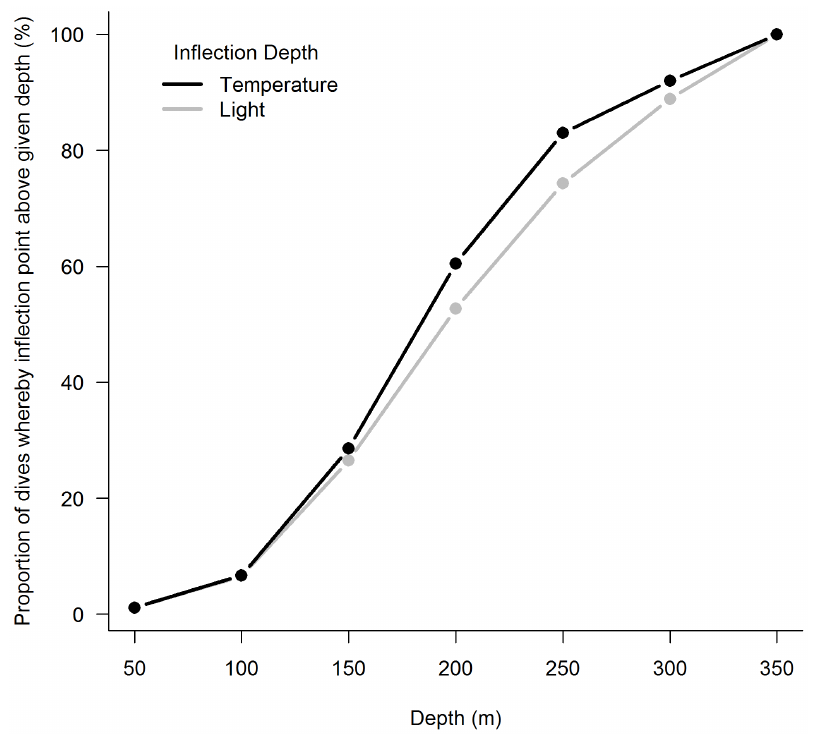
Figure 2. Proportion of dives whereby greatest temperature and light inflection points are above a given depth.